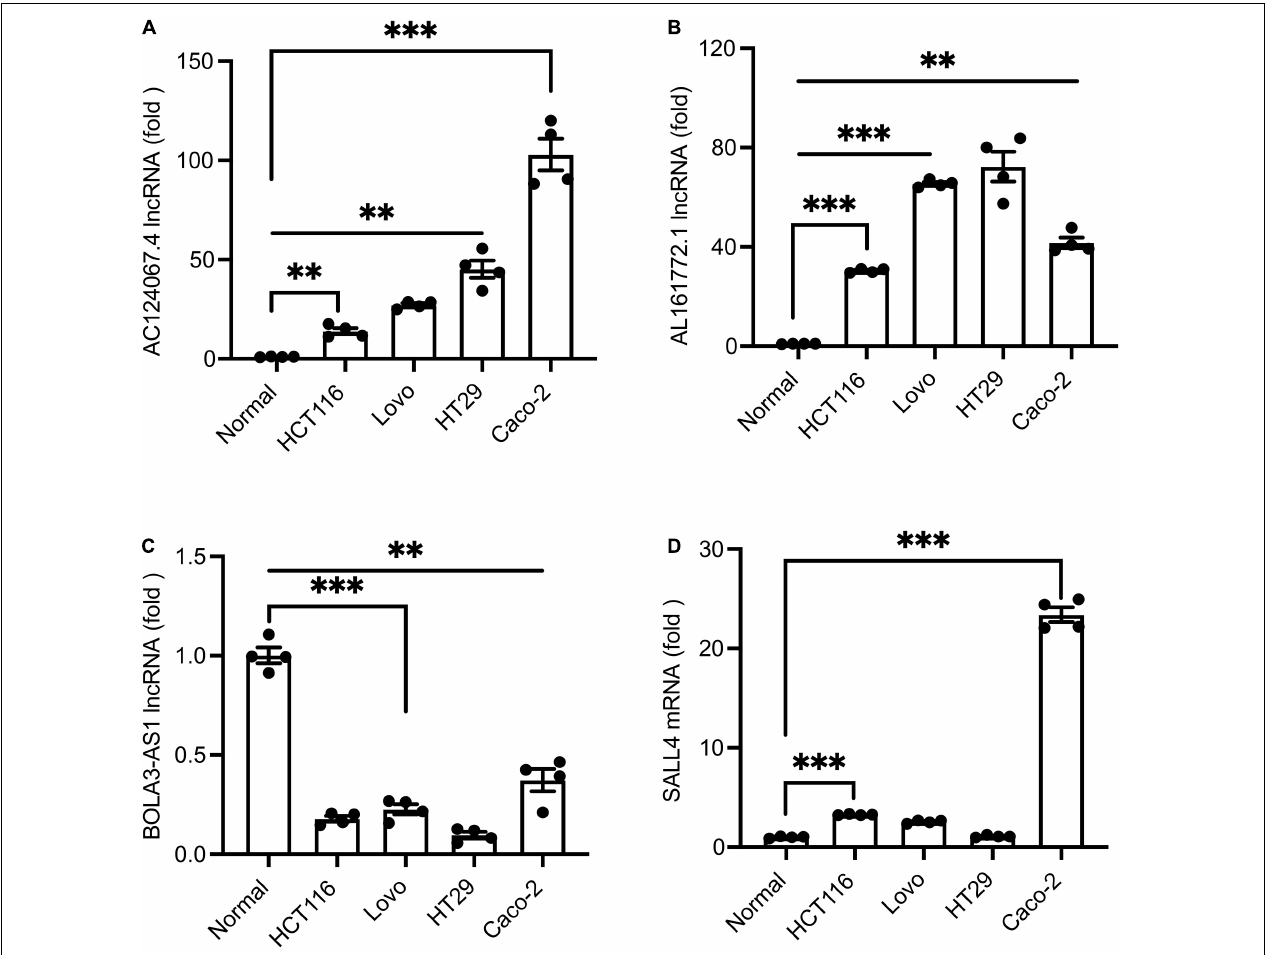
FIGURE 6 | (A–D) qPCR verification of the expression levels of differential lncRNAs in COAD cell lines and normal cells. Values are shown as the mean ± SEM ( n = 4). *** p < 0.001 and ** p < 0.01 by Student’s t -test. Normal cells were employed as